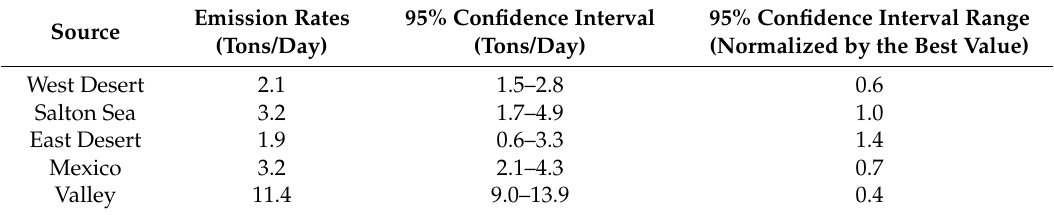
Figure 7. (a) Model performance for monthly averaged data (red lines show factor of 1.5 of Figure 7. ( a ) Model performance for monthly averaged data (red lines show factor of 1.5 of observation). observation). ( b ) Emission rates from different source categories. ( b ) Emission rates from different source categories. Table 2. Emission rates calculated by the model using monthly averaged Table 2. Emission rates calculated by the model using monthly averaged data.